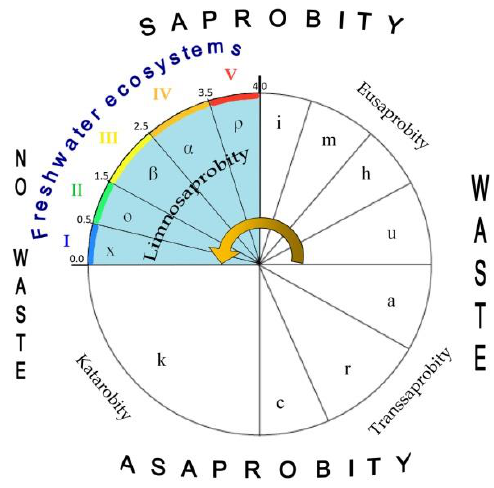
Figure 4. Saprobity model according to [35]. Each quadrant (Katarobity, Limnosaprobity, Eusaprobity, and Transsaprobity) symbolize four main groups of water variables (Table 2 with respect to purity and pollution [35] (p. 34). The blue quadrant corresponds to the freshwater ecosystems. The symbols: x, o, β , α , p, denote the self-purification zones, which are used to determine Classes of water quality I–V, which are colored by EU codes [19]. Yellow arrow gives the self-purification process direction. Table 2. Major trophic-related variables for freshwater aquatic ecosystems according to [33,34,36].